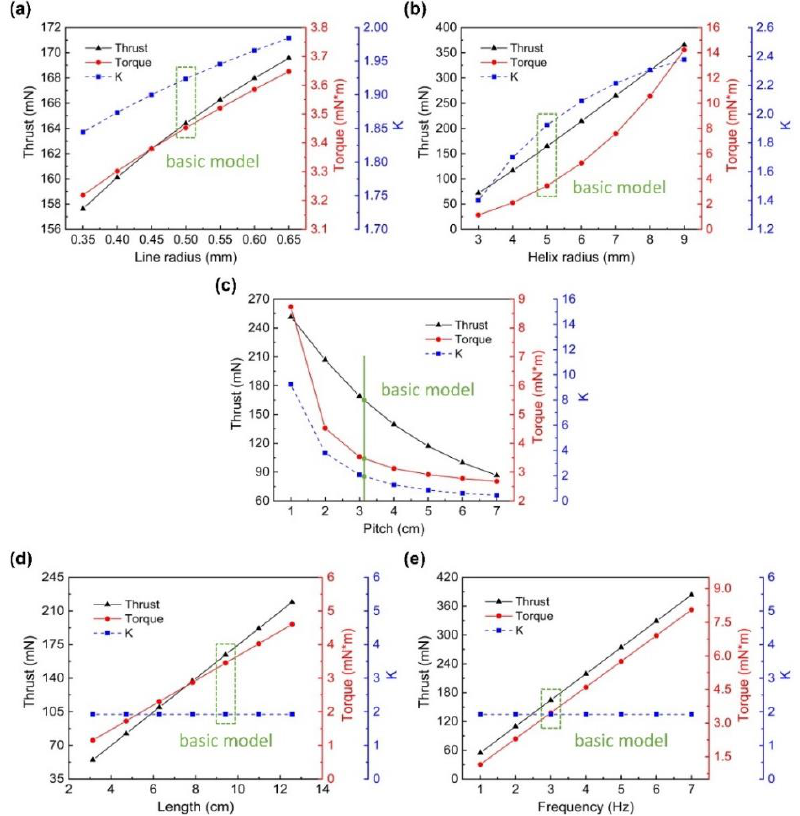
Figure 3. The influence of five parameters (( a ) Line radius, ( b ) Helix radius, ( c ) Pitch, ( d ) Length, and ( e ) Frequency) on the three propulsion performance indexes (thrust-black line, torque-red line, and K-blue line). The locations of the basic model are marked in green.